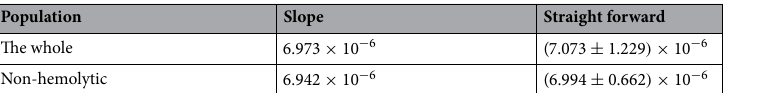
Population Slope Straight forward The